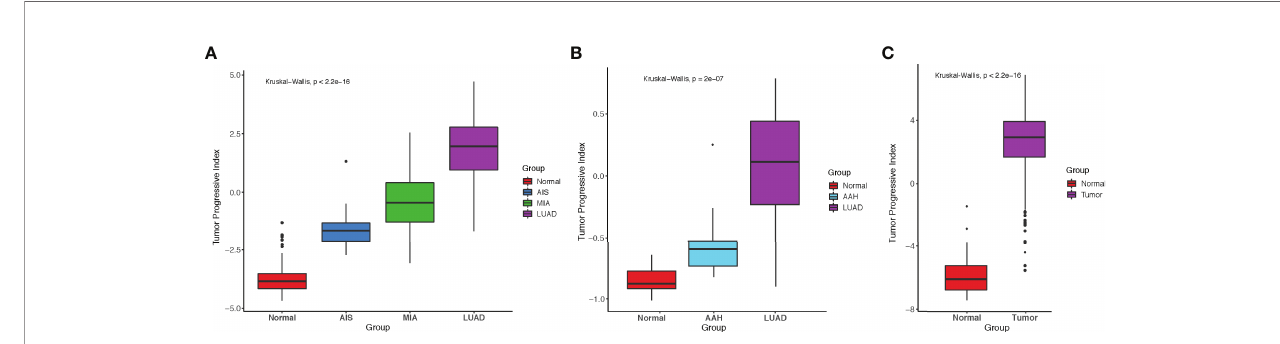
FIGURE 5 | Comparison of tumor progressive index for different datasets. (A) Boxplot showing the index increased as tumor progressed in the FUSCC cohort. (B) Boxplot showing the index increased as tumor progressed in Dejima ’ s cohort. (C) Boxplot showing the difference of tumor progressive index between normal and tumor samples in the